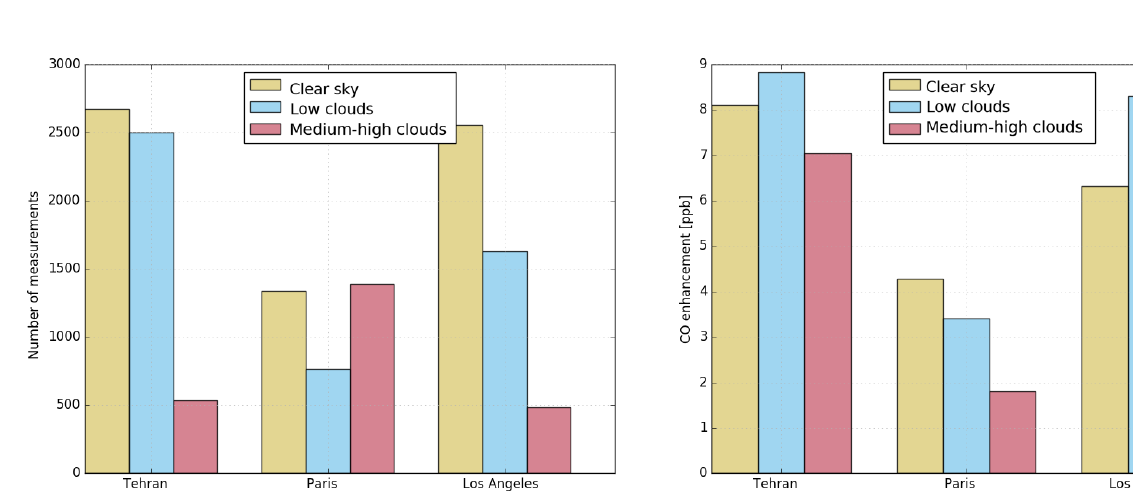
Figure 10. Number of individual SCIAMACHY CO retrievals un- der clear-sky (yellow), low-cloud (blue) and medium–high-cloud (pink) atmospheric condition for the time range and latitude– longitude box specified in Figs. 7, 8 and 9.